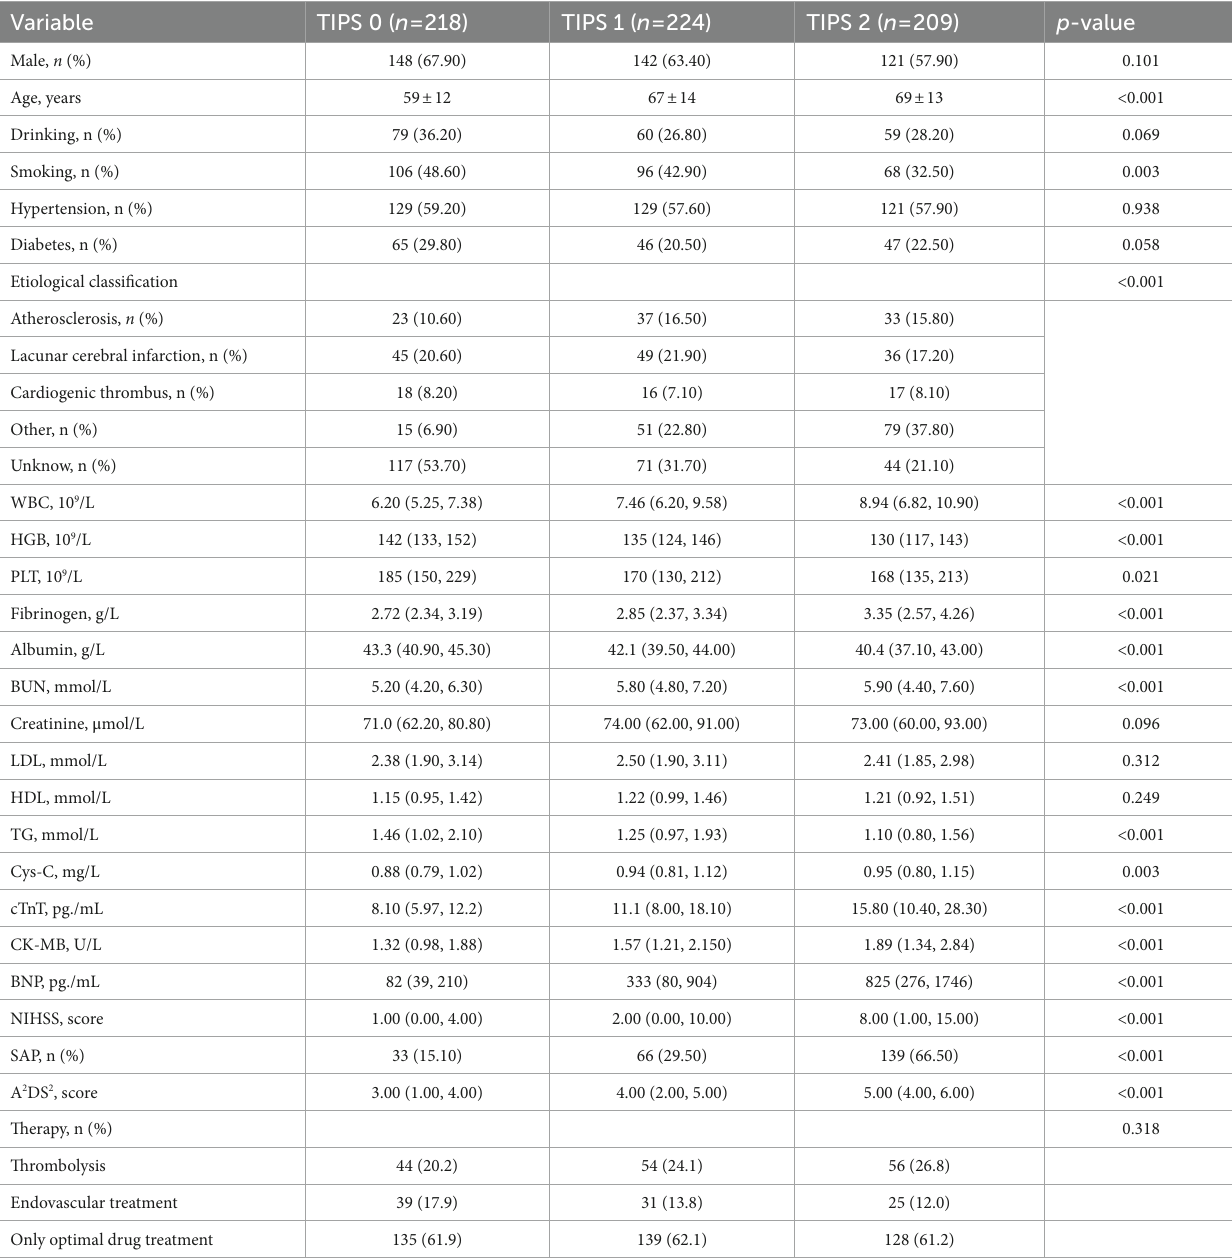
TABLE 1 Relationships between clinical characteristics and the thrombo-inflammatory prognostic score (TIPS) in patients with stroke-associated pneumonia in derivation set.